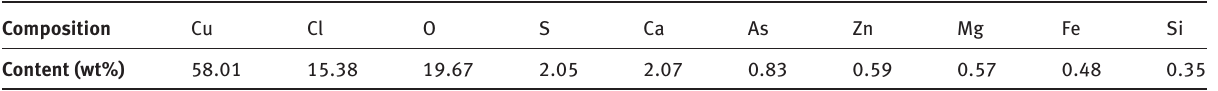
Table 1: The chemical composition of raw CuCl residue Composition